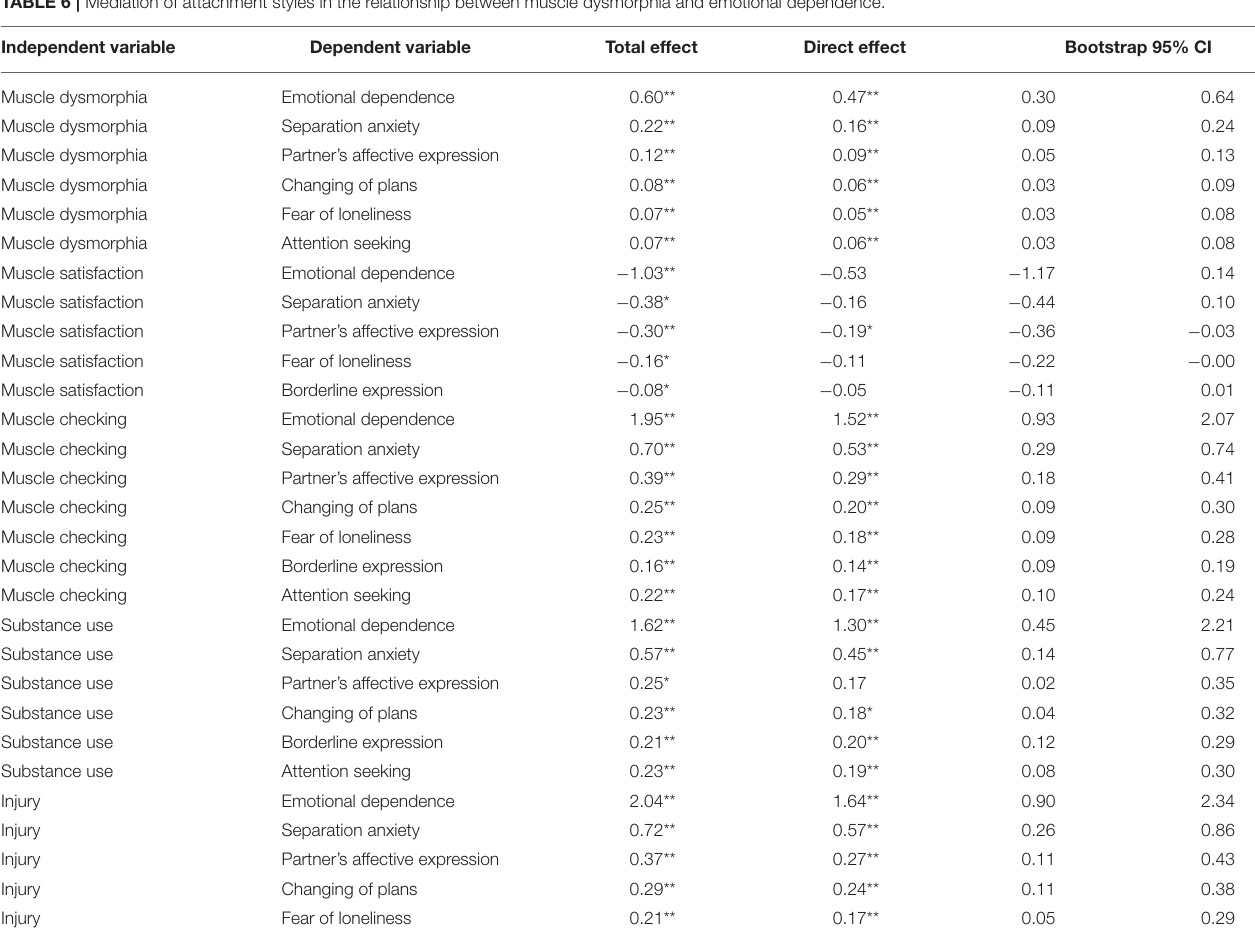
TABLE 6 | Mediation of attachment styles in the relationship between muscle dysmorphia and emotional dependence. Independent